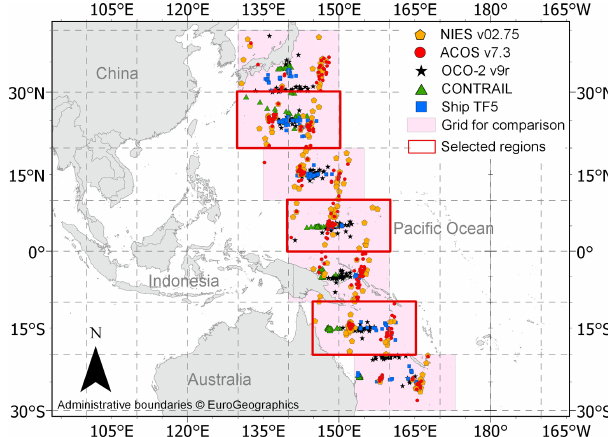
Figure 1. Location of monthly averaged data of CO 2 from air- craft (CONTRAIL, green triangle), ship (Trans Future 5 – TF5, blue squares), the satellite retrievals from NIES (yellow diamonds), ACOS (red circles), and OCO-2 (black stars) between 2014 and 2017. Selected regions within 10 ◦ latitude by 20 ◦ longitude boxes are shown in red frames. Administrative boundaries © EuroGeo- graphics.